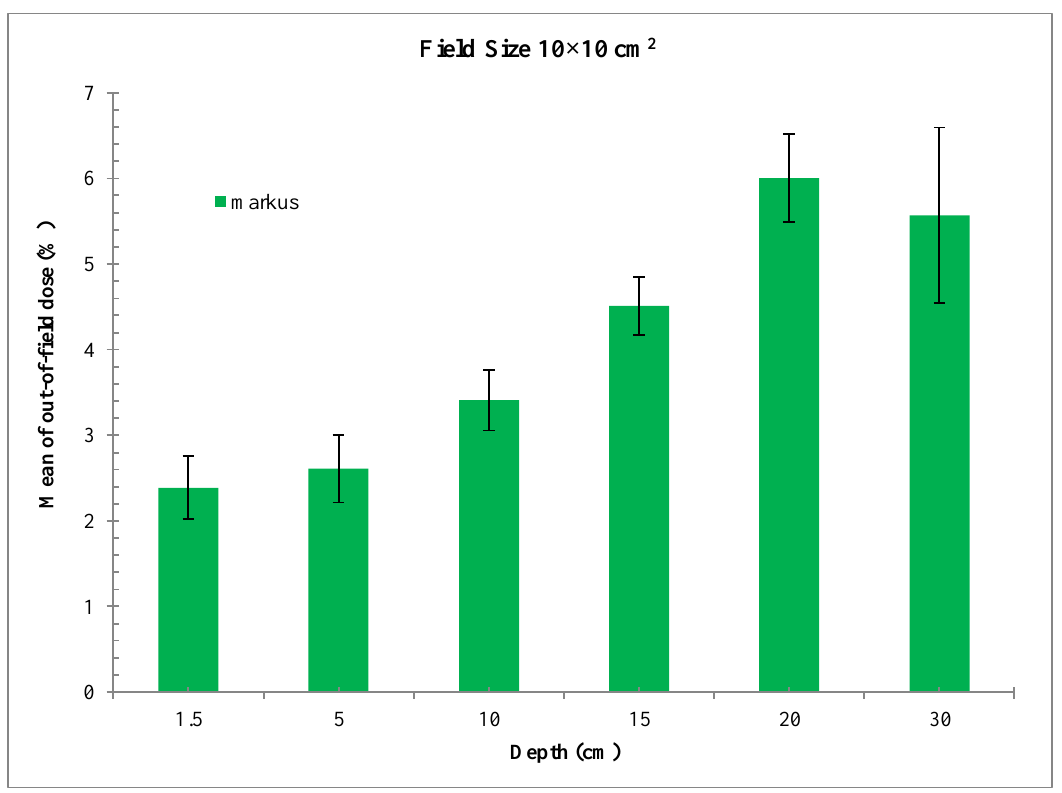
Figure 4. Variation of out-of-field dose with different depths (1.5, 5, 10, 15, 20 and 30 cm) using Markus ionization chamber